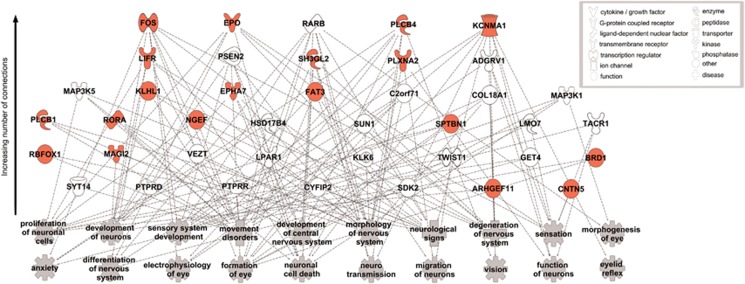
Summary of Ingenuity Pathway Analysis (IPA) using genes encoding the top 200 SNPs associated with initial pursuit acceleration and pursuit maintenance within the study population (N=849). The functional category nervous system development and function was identified as one of the top five physiological systems represented by these genes. Genes listed from the top have the greatest number of connections to functional categories within the nervous system development category listed in the lower panel. Genes that have shown evidence for a relationship to psychotic disorders are highlighted in red. SNP, single-nucleotide polymorphism.